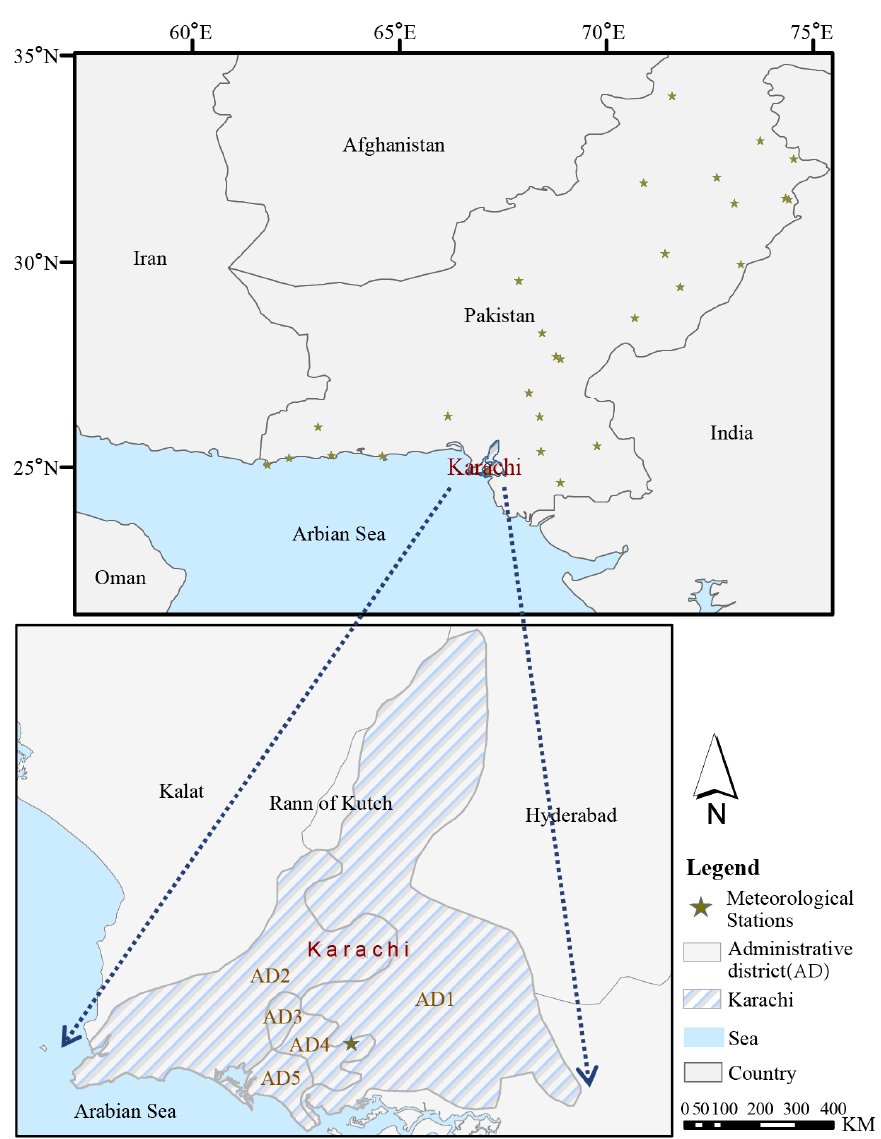
Figure 1. Geographical map of Karachi. The enlarged map showed the administrative district (AD) of Karachi, including Malir (AD1), Karachi West (AD2), Karachi Central (AD3), Karachi East (AD4) and Karachi South (AD5).